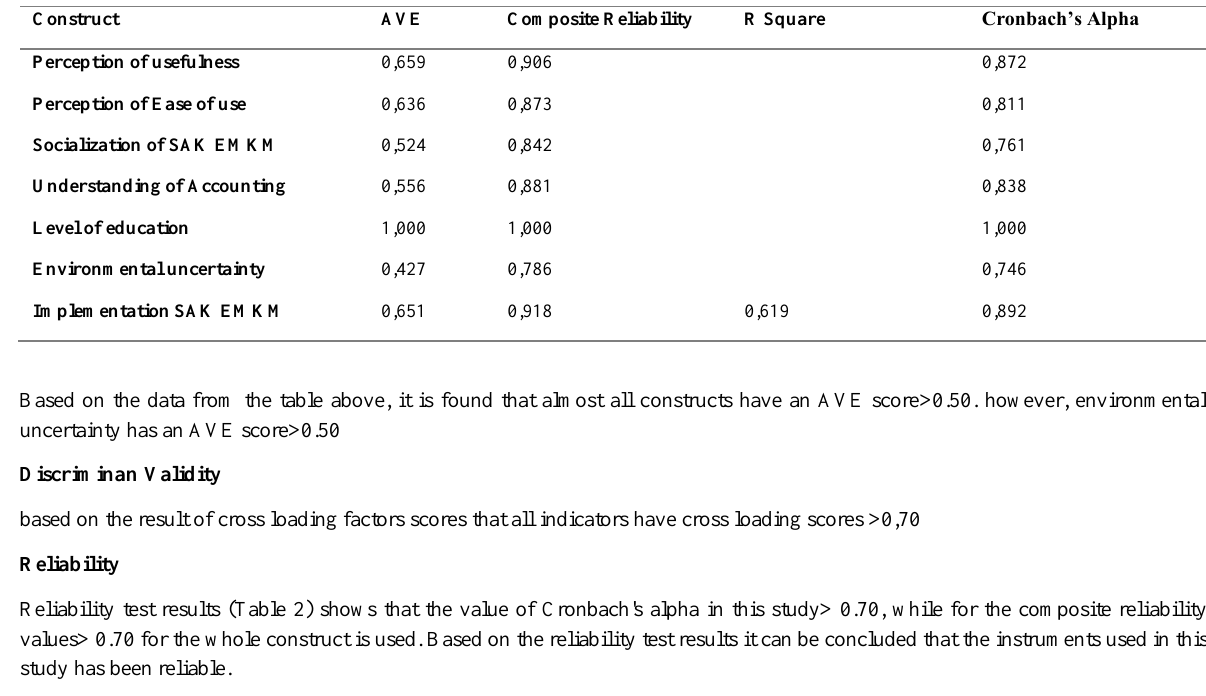
Table 2: Validity and Reliability Test